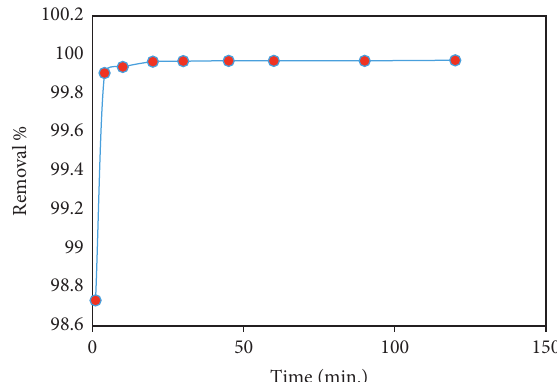
Figure 9: Effect of time equilibrium on the removal percentage of Pb (II).